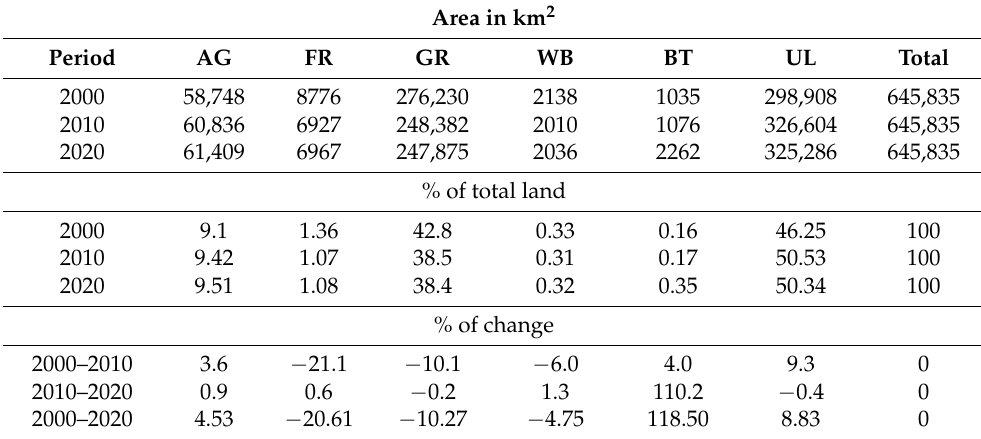
Table 5. Magnitude of LULC change in Afghanistan.